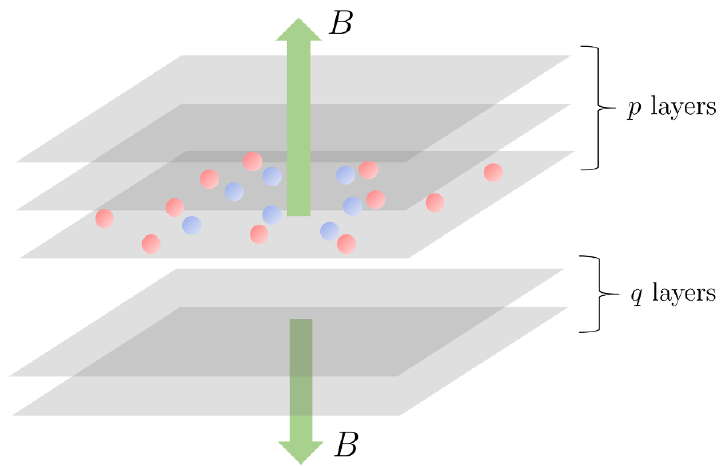
Figure 2 . N vortices (red) and M antivortices (blue) in multiple p layers under the influence of vertically upward magnetic field B and q layers under that of the downward magnetic